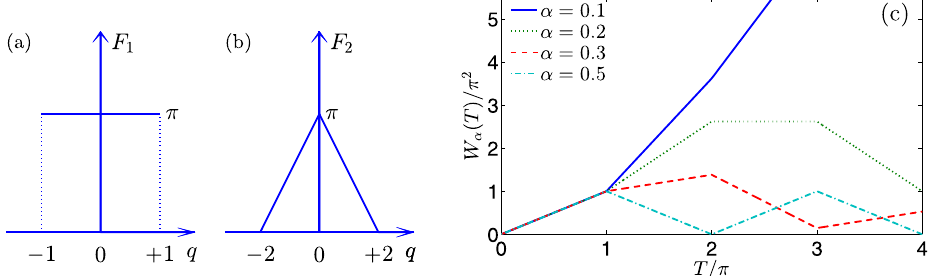
Figure 1 . (Color online) (a) Fourier transform of the function sinc x and (b) Fourier transform of its square sinc 2 x . The latter is calcu- lated from the former by convolution. The point is that both have a fi nite support. In (c), the function W α ( T ) [see Eqs. (5) and (10)], which is calculated by using the Poisson summation formula and the fact in (b), is displayed for four different values of the offset α . It is piecewise linear. In the interval of 0 ≤ T ≤ π , its value is independent of the parameter α ; while beyond this interval, its value is very sensitive to α . Note that for α = 0.5, W α returns to zero at T = 2 m π periodically; while for α = 0, W α ∝ T 2